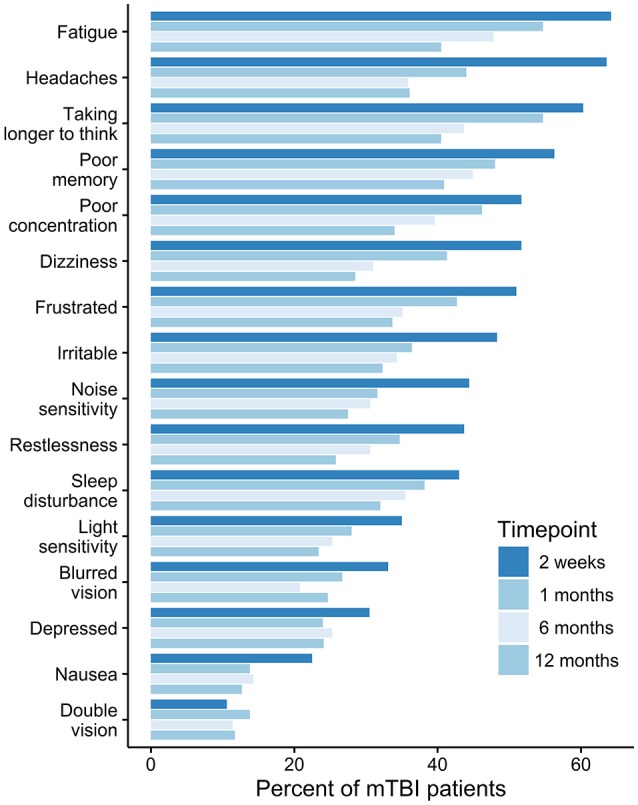
The prevalence of post-concussion symptoms over time. Permission has been obtained to base our figure on data presented in Theadom (27).